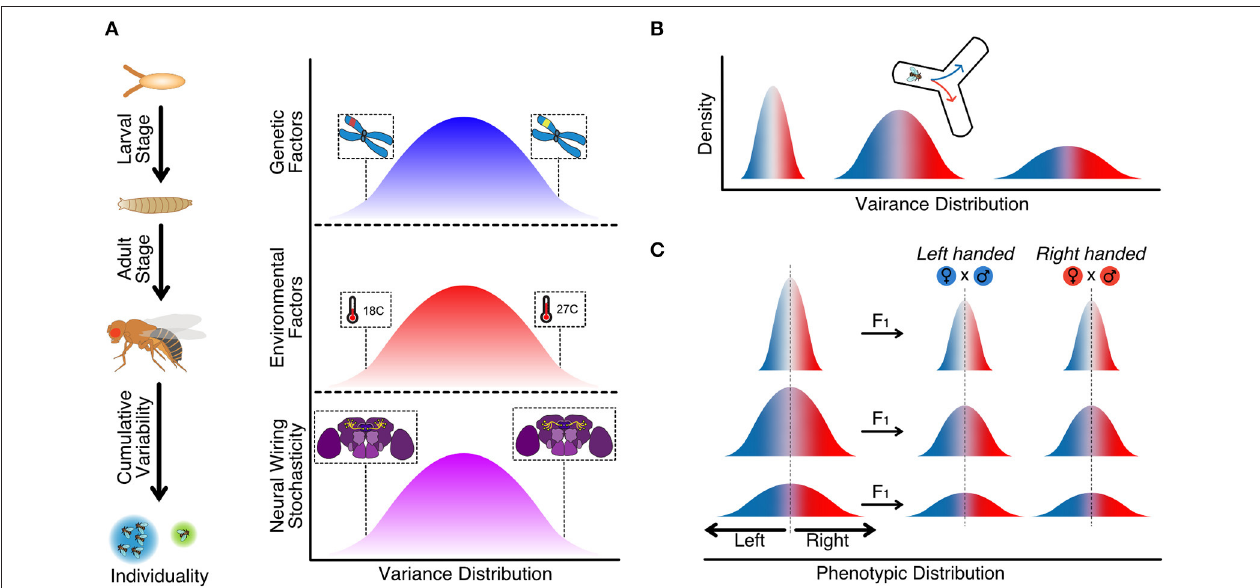
FIGURE 1 | (A) Cumulative and relative contribution of different sources of interindividual variability from early development stages to adult life experience. Individuality emerges from the combination of genetic factors, environmental factors, and stochastic factors. (B) Variance distribution for a given phenotypic trait evoking variability among individuals within a population ( Buchanan et al., 2015). (C) Variance distribution of phenotypic handedness is inherited to next generations within a population ( Ayroles et al.,